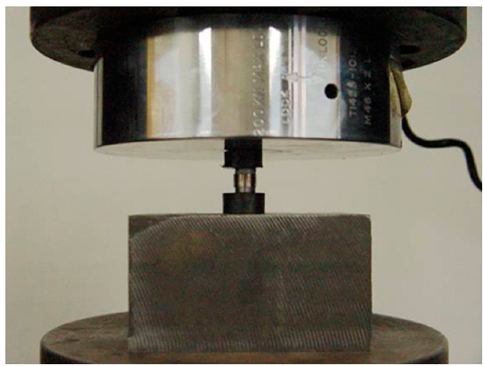
Figure 1. Photograph of NiTi shape memory alloy (SMA) tube undergoing radial loading test.